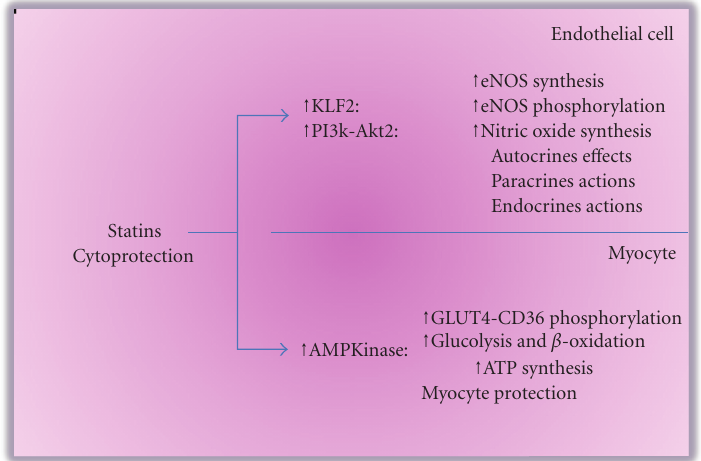
Figure 3: Statins, mechanisms, and myocyte-protective e ff ects. Statins increase the expression of KLF2 and eNOS synthesis and also increase the activation of eNOS and nitric oxide production. In the myocyte the activation of AMPK increases the income and energy substrate utilization, as well as the production of